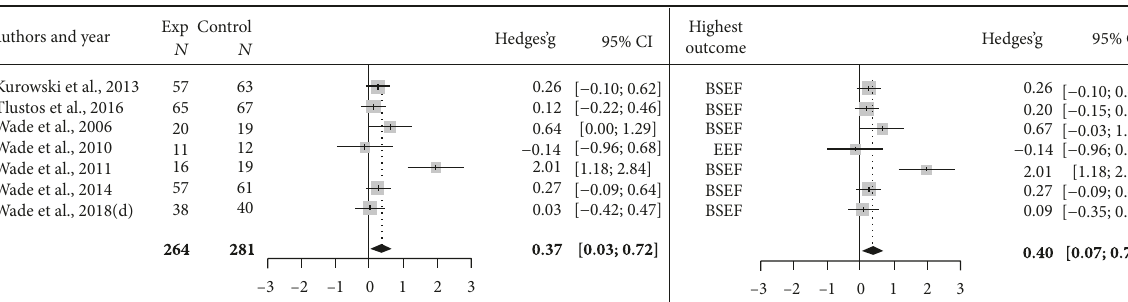
Figure 3: Forest plots showing the number of participants per group, e ff ect size estimates (Hedges ’ s g ), and 95% con fi dence interval of each study, comparing behavioral training outcomes with control condition ’ s outcomes. Model Behavioral A depicts the meta-analytic model that considers, for each study, an aggregated mean representing the mean value of the various outcomes relative to all behavioral domains. Model Behavioral B depicts the meta-analytic model that considers, for each study, the highest outcome domain. Note: BSEF=behavioral, social, and emotional functioning; EEF =everyday executive